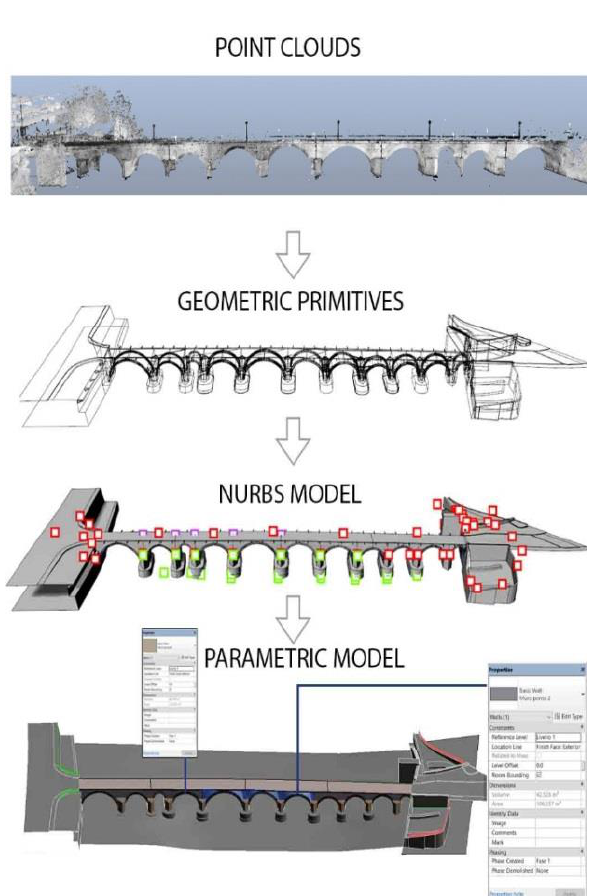
Figure 6. The Generative process. From Point Clouds to Parametric Model (LoD 500).